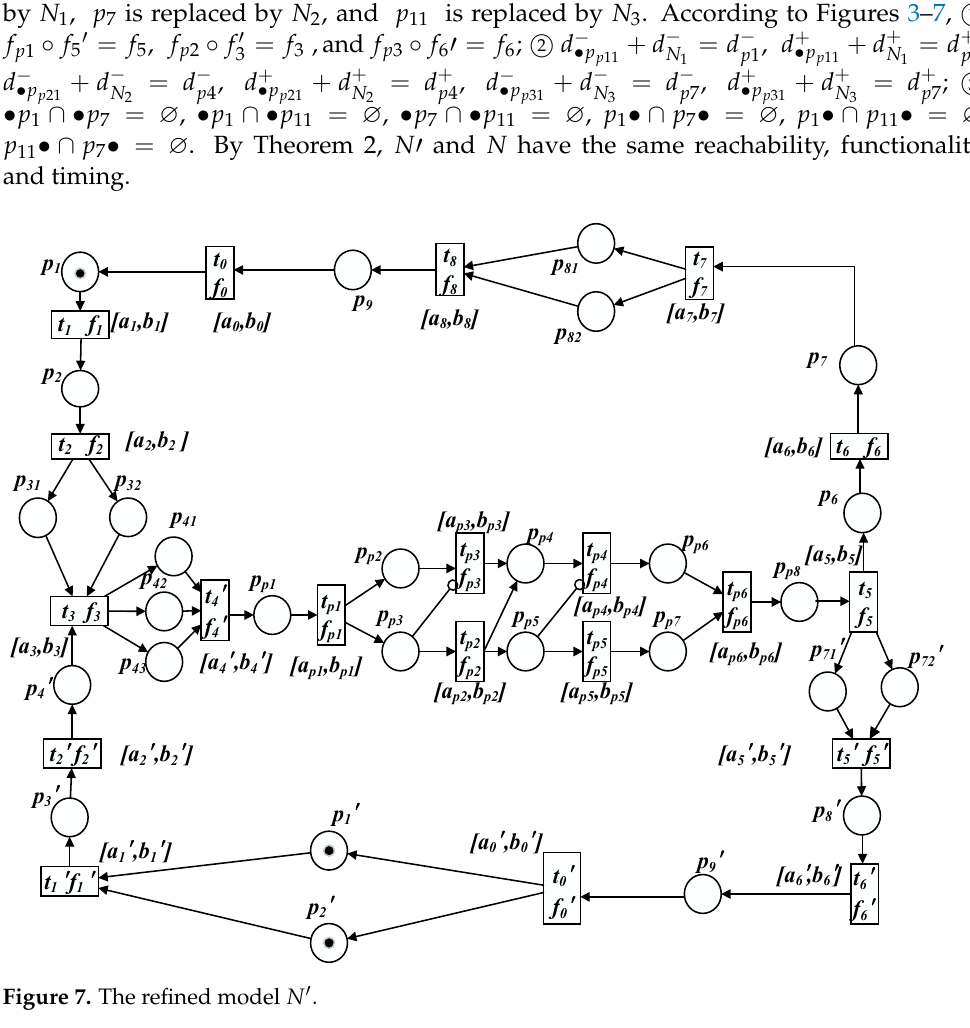
Figure 6. The subnet model 𝑁 (cid:2871) .